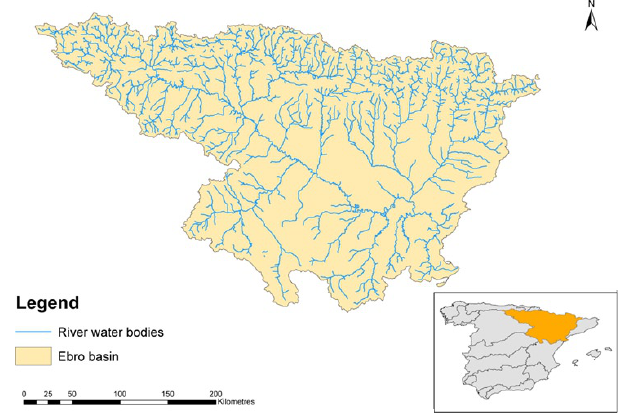
Fig. 1. Case study: the Ebro River basin and its management areas source: (CHE, 2011) (available at: http://www.chebro.es/ contenido.visualizar.do?idContenido=12011&idMenu=2224 last access: 27 January 2012). Source: Authors’